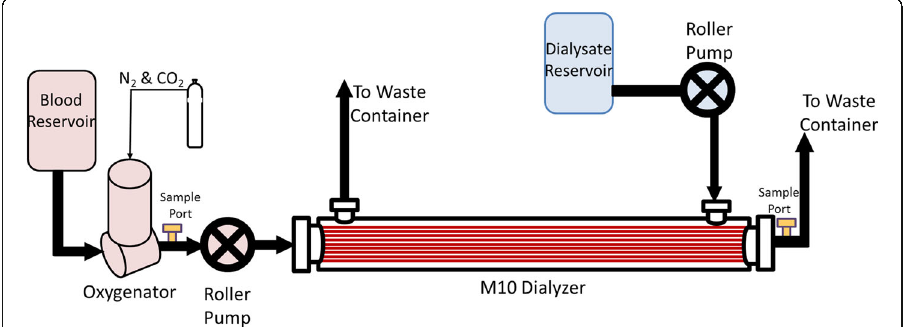
Fig. 1 Schematic of the in vitro, single-pass CO 2 removal setup. Blood was pumped through the inside of the dialyzer fibers while dialysate was independently pumped over the outside of the fibers. The oxygenator conditioned the blood, and blood samples were taken before and after the